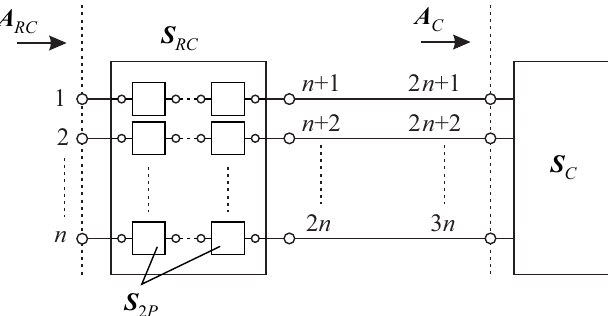
Figure 1. Block diagram of S-parameters of an n-channel coil array S C and receiver chain S RC that are used to model the noise of the network. Incoming wave vectors A RC and A C will be needed to calculate the maximum available signal-to-noise ratio (SNR) of the network by weighing the magnetic field vector B ν ( r ) gathered from an electromagnetic field solver. The individual two-port matrices S 2 P describe the noise of all components of the receiver chain.